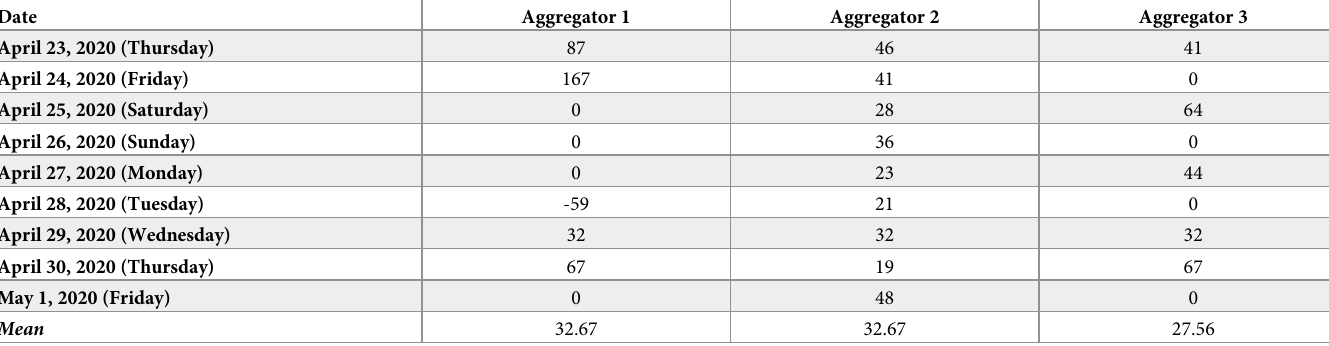
Table 2. Number of new COVID-19 cases by date and